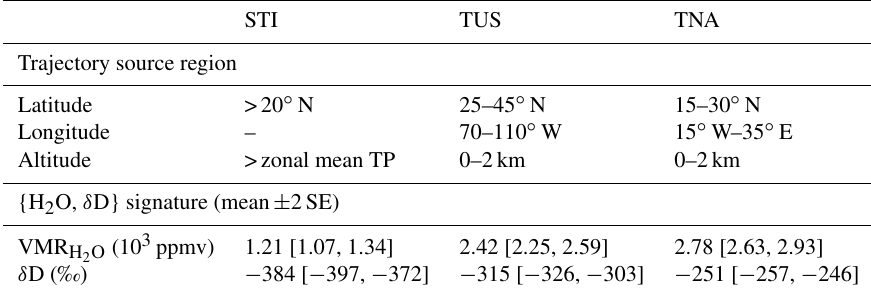
Table 2. Backward-trajectory classification by source region and resulting distributions of deseasonalized VMR H range-transport patterns of stratospheric intrusions (STIs), transport from North America (TUS), and transport from northern Africa